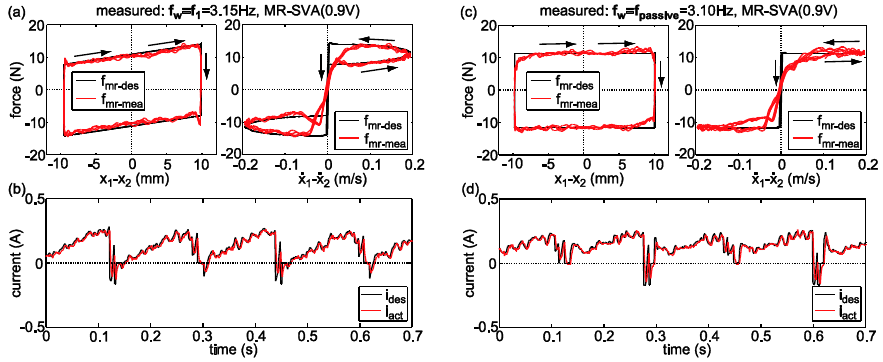
Figure 15. Measured force tracking control for ( a , b ) small positive desired stiffness due to f w = f 1 > f passive and ( c , d ) zero desired stiffness due to f w = f passive